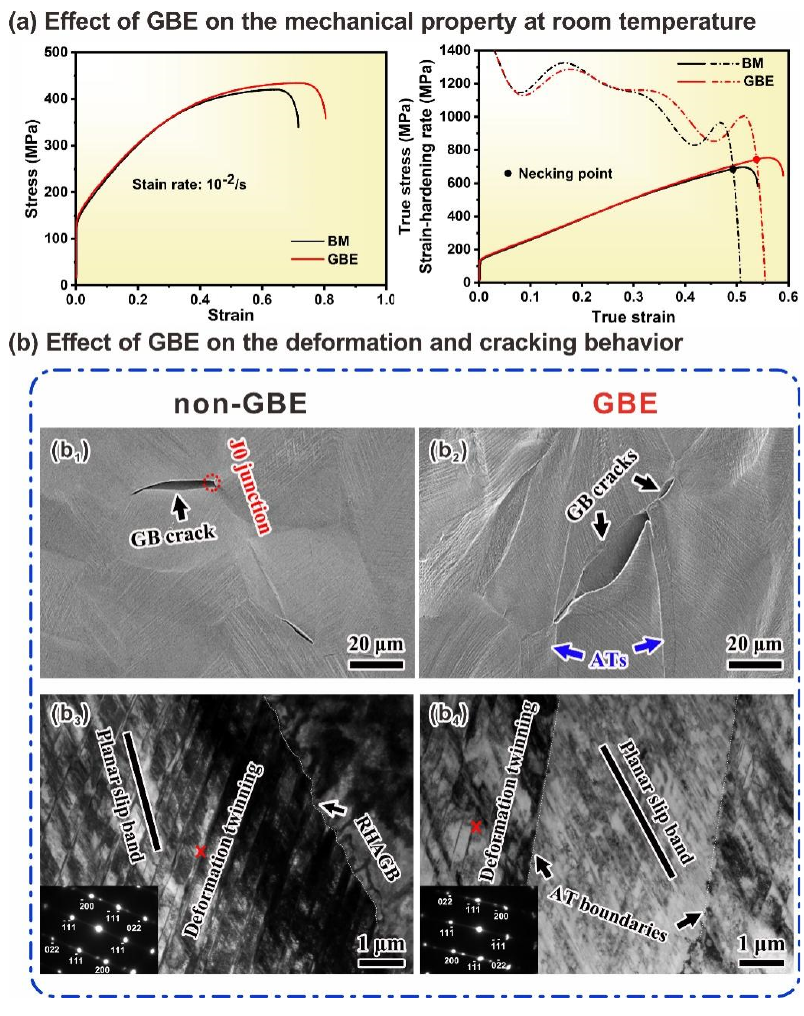
Figure 5. Effect of GBCD optimization on the room-temperature tensile properties of the Cu-16at.% Al alloy ( a ) Comparisons of the tensile properties of non-GBE and GBE samples ( b ) Influences of GBE on the deformation (b 3 , b 4 ) and cracking (b 1 , b 2 ) behaviors adopted from Ref. [6]